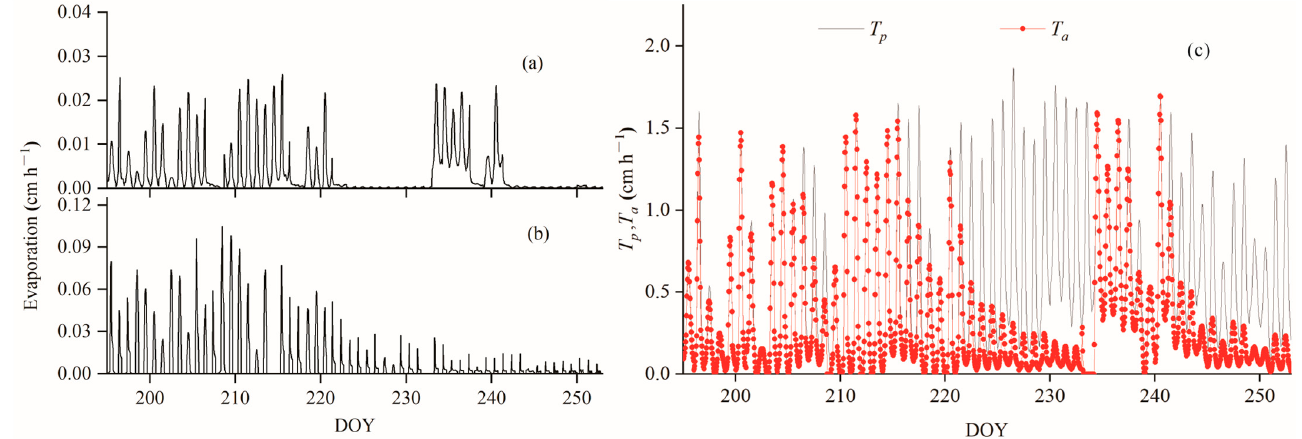
Figure 6. Variation of the evaporation rates for SMT ( a ) and BT ( b ) and simulated potential and actual transpiration rates ( T p and T a , respectively) for SMT ( c ) during the period from 15 July to 10 September (day of the year (DOY) 196 to 253).